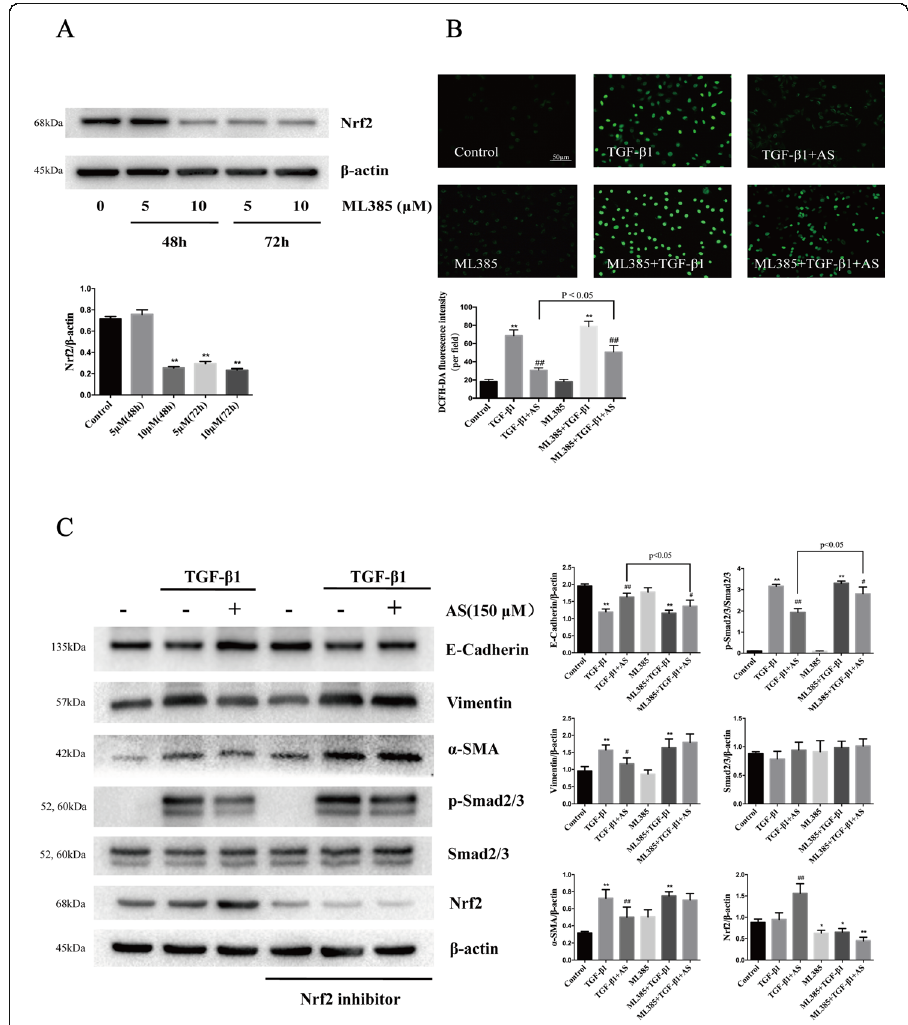
Fig. 7 The role of Nrf2 activation in the inhibitory effect of asiaticoside on TGF- β 1-induced MMT and ROS production in HPMCs. Notes: (A) After HPMCs treatment with two concentration of ML385 (5, 10 μ M) and subsequently incubation for 48 h and 72 h, Nrf2 was analyzed by immunoblotting. Data are shown as the mean ± SEM, *p < 0.05 vs. control, **p < 0.01 vs. Control. (B) HPMCs were divided into a vehicle group, a TGF- β 1 group (treated with 10 ng/ml TGF- β 1), a TGF- β 1 + asiaticoside group (treated with 150 μ M asiaticoside + 10 ng/cm 3 TGF- β 1), a ML385 group (treated with 10 μ M ML385 for 72 h), a ML385 + TGF- β 1 group (pretreated with ML385 at 10 μ M 72 h prior to 10 ng/cm 3 TGF- β 1), and a ML385 + TGF- β 1 + asiaticoside group (pretreated with ML385 at 10 μ M 72 h prior to 150 μ M asiaticoside + 10 ng/cm 3 TGF- β 1). After incubation for 24 h, DCFH-DA fluorescence in cultured cells was analyzed by fluorescence microscopy (scale bar = 50 μ m). Quantitative measurements of the fluorescence intensities were conducted using ImageJ software. (C) Immunoblot was performed to detect MMT markers, Smad-related proteins and Nrf2 expression. Data are shown as the mean ± SEM, *p < 0.05 vs. control, **p < 0.01 vs. control; #p < 0.05 vs. TGF- β 1 treatment; ##p < 0.01 vs. TGF- β 1 treatment. Abbreviations: AS, asiaticoside; TGF- β 1, transforming growth factor- β 1; Nrf2, nuclear factor erythroid-2-related factor 2; p-Smad2/3, phosphorylated Smad2/3; ML385, Nrf2 inhibitor; ROS, reactive oxygen